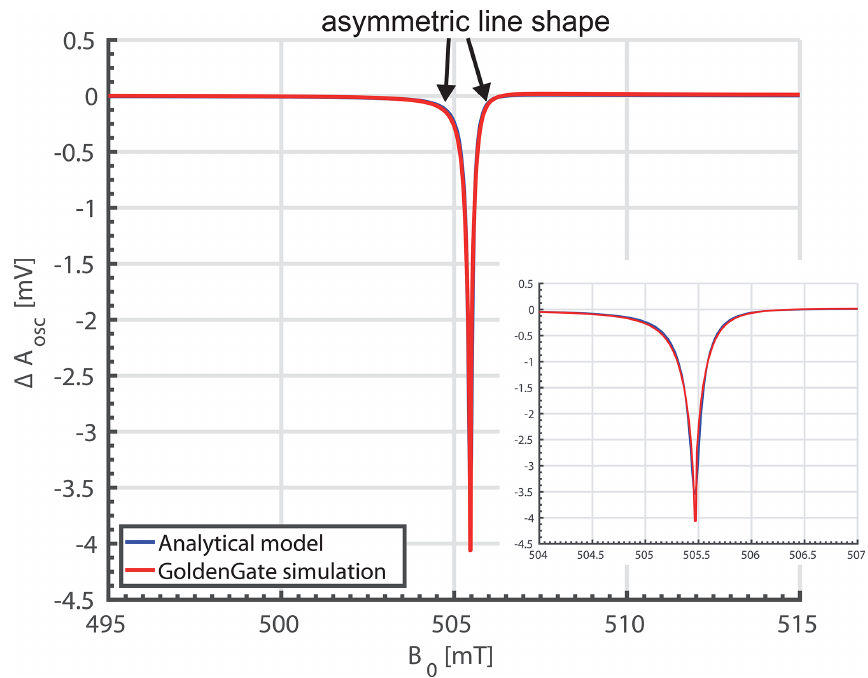
Figure 4. Comparison of the proposed analytical model for the amplitude variation in amplitude-sensitive ESR and GoldenGate simulations. The corresponding simulation parameters are f osc = 14 . 209GHz, L coil = 582 . 5 pH, Q coil = 10 . 2 and V TUNE = 2 . 8V, corresponding to C ( V TUNE ) = 103fF. Loading of the previous stage was accounted for by load capacitors of C L = 75fF to ground on both the positive and the negative oscillator output (AC coupled through 700fF), transistor length L = 120nm, transistor width W = 12µm, 24 fingers, technol- ogy: GFUS 130nm CMOS, I BIAS = 1 . 75mA, ηχ 0 = 0 . 2 × 10 − 3 · 10 − 4 , T 2 = 60ns, L spins = 100 pH. C spin and R spin were automatically calculated for each sweep point from Eq. (25). Furthermore, the condition for a nonsaturated sample, i.e., ( γ B 1 ) 2 T 1 T 2 (cid:28) 1, was ensured. Inset: an enlarged view of the amplitude dip in both models.